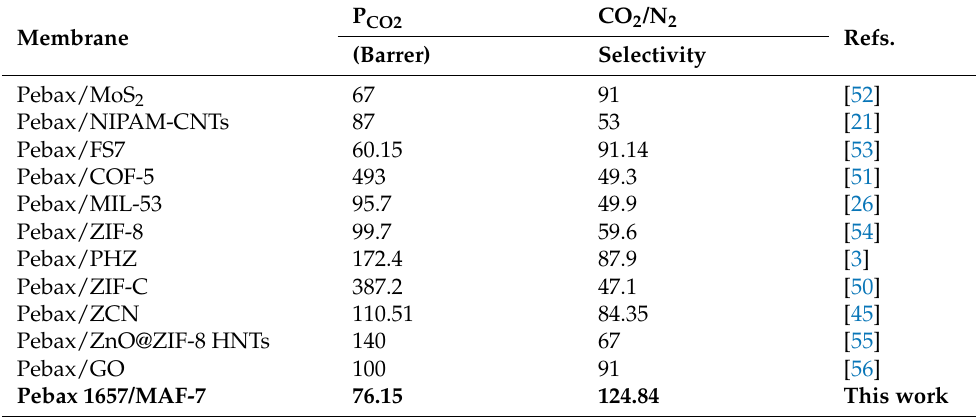
Table 2. Comparison of Pebax 1657/MAF-7 MMMs with previous publications.